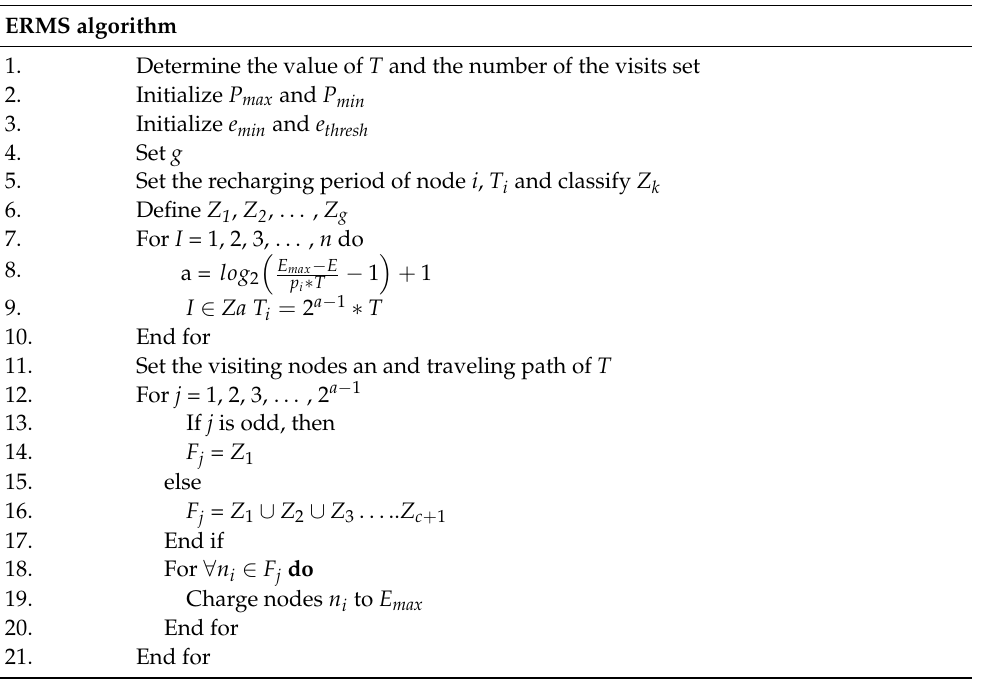
Algorithm 1. ERMS